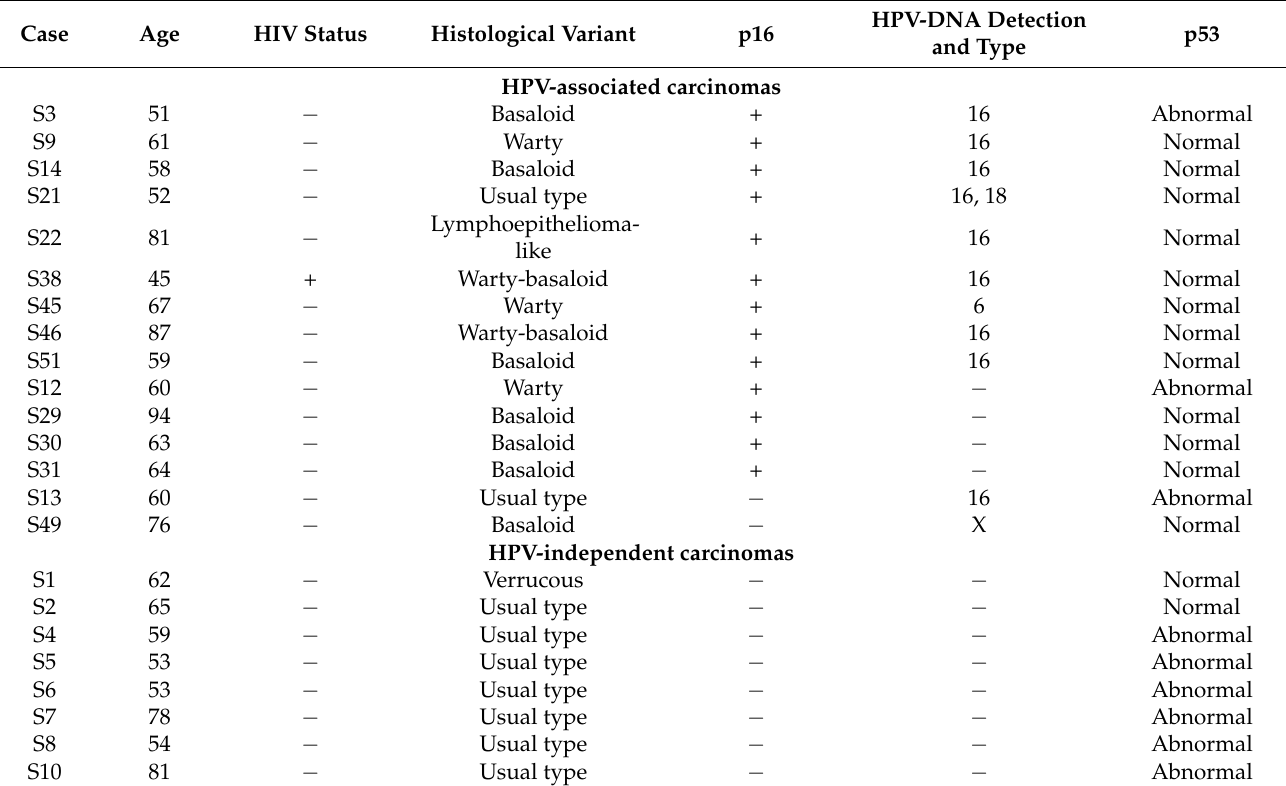
Table 2. Age, HIV status, histological variant, Human Papillomavirus (HPV)-DNA result, p16 and p53 immunohistochemical features of the tumors from